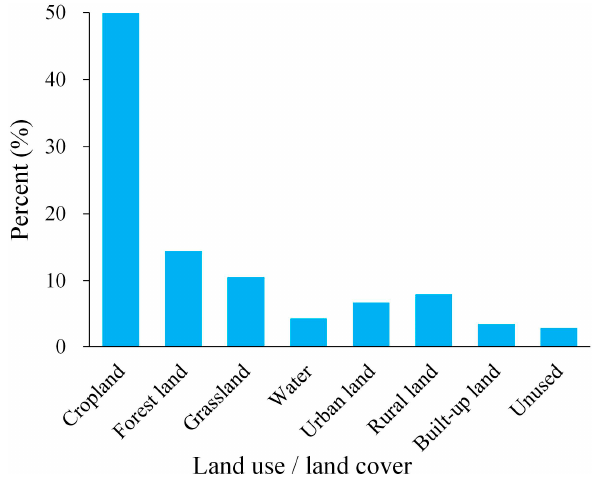
Figure 2. Proportions of lighted pixels at night for different types of land use/land cover across China in 2015.